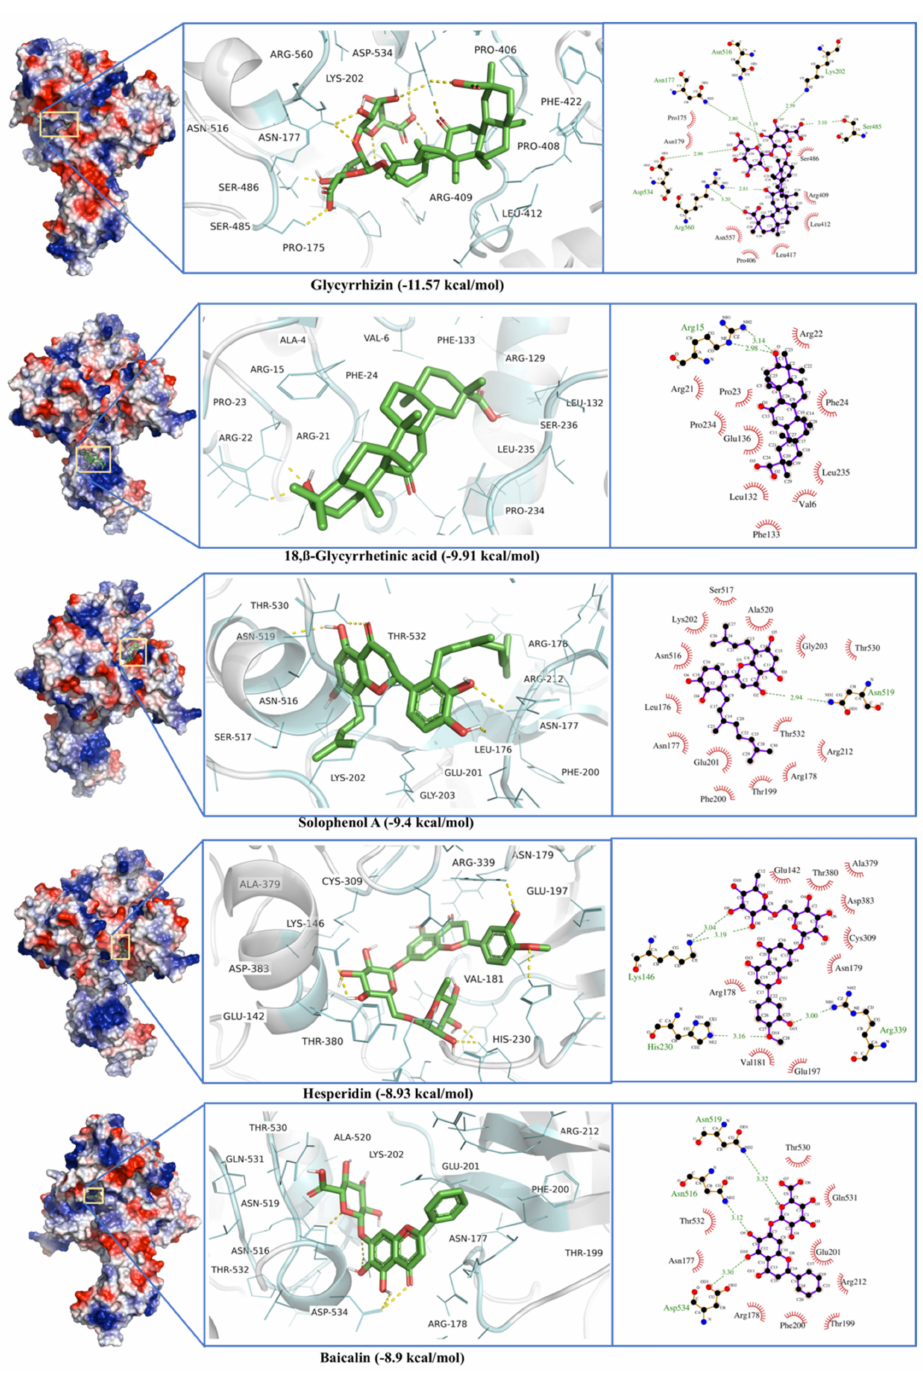
Figure 10. Glycyrrhizin, β -Glycyrrhetinic Acid, Solophenol A, Hesperidin, and Baicalin docking to helicase of SARS-CoV-2 Spike protein